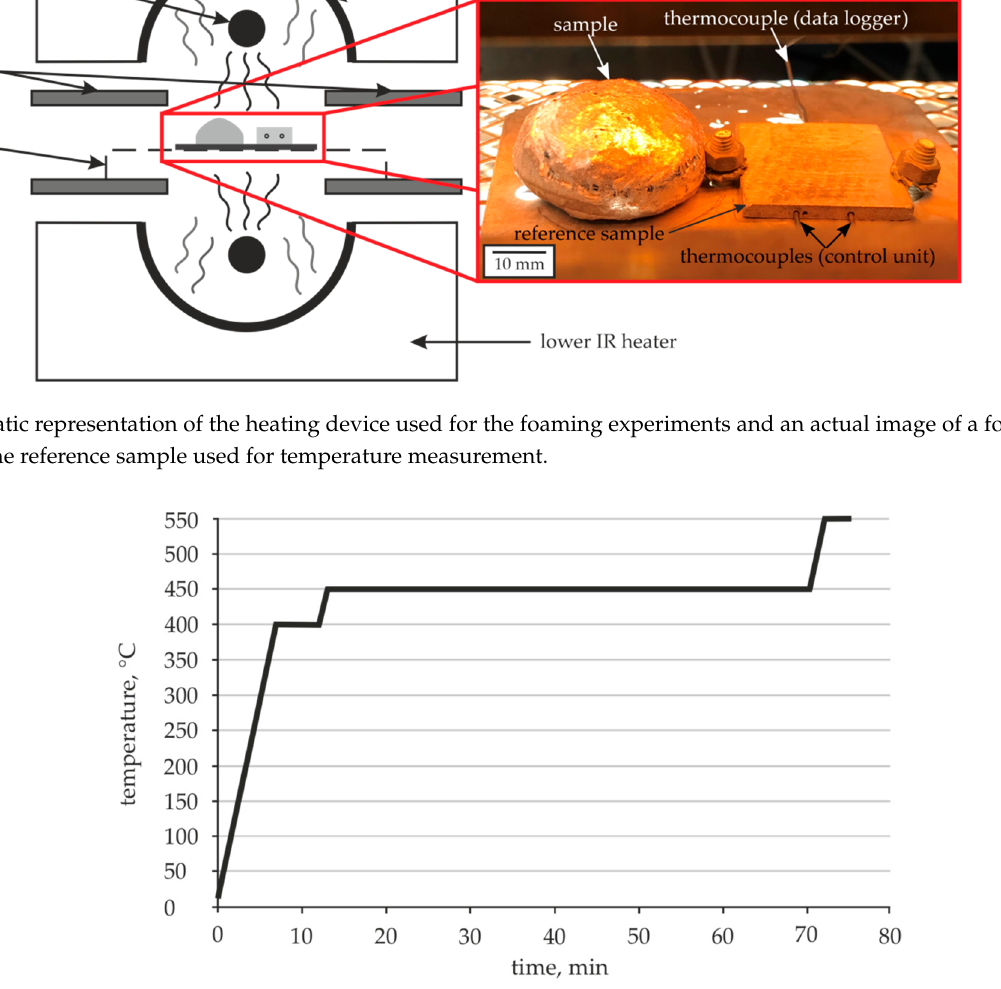
Figure 5. Schematic representation of the heating device used for the foaming experiments and an actual image of a foam sample next to the reference sample used for temperature measurement.